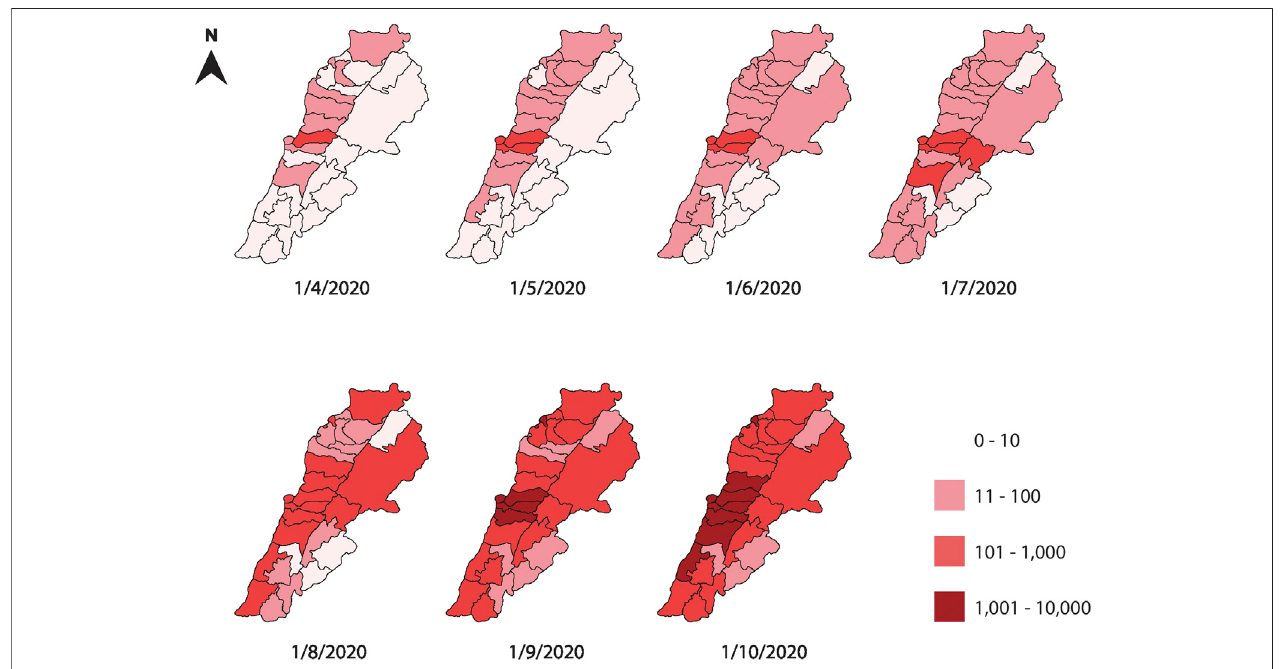
FIGURE1| AmonthlymapoftheregionalcumulativenumberofinfectionsinLebanesedistrictsbetweenAprilandOctober2020.The fi gureshowsatimeseriesof theinfectionspread,usingalogarithmicscaletoaccountfortherapidincreaseinthenumberofinfections.ThecentralneighboringdistrictsofBeirutandMountLebanon are the most infected throughout the time span